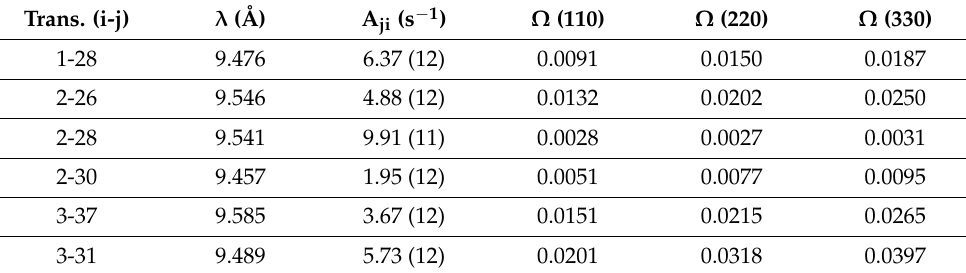
Table 7. Atomic data for Fe XXI X-ray lines.